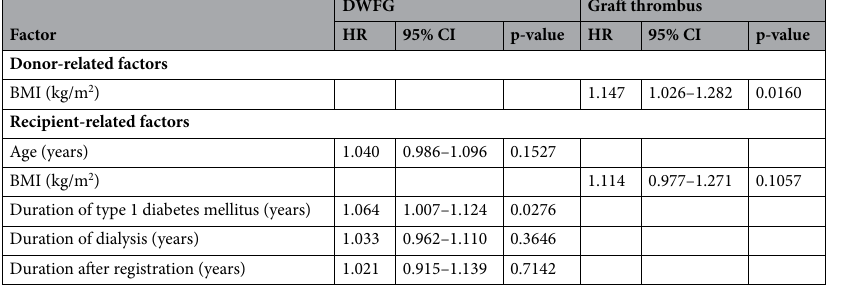
Table 5. Multivariate analysis of preoperative factors potentially influencing pancreas graft loss due to DWFG or graft thrombus after PTx. Cox proportional hazards regression used significant factors from the